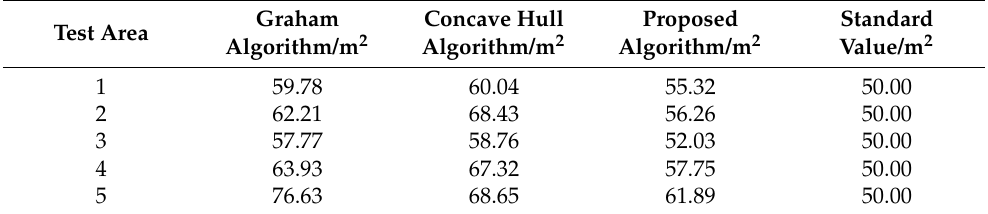
Table 1. Statistical table of area of different measurement areas by different